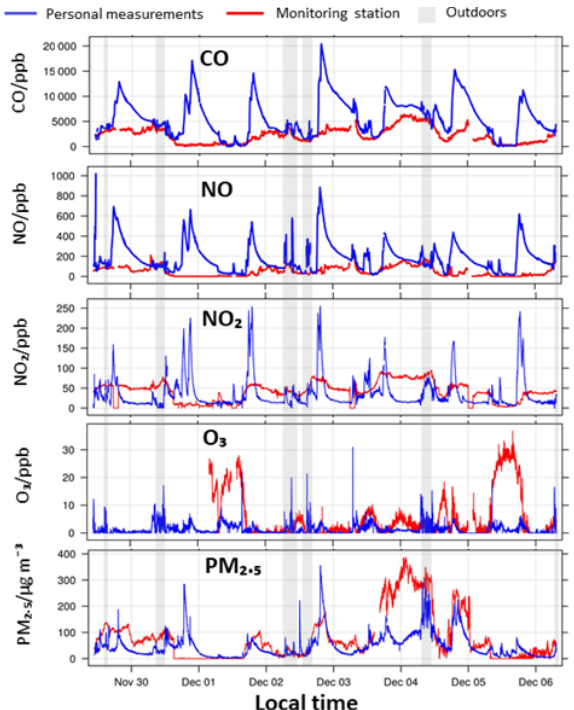
Figure 8. Time series of the air pollution exposure of participant U123 in the AIRLESS project (heating season). Personal exposure measurements (blue) are compared to data from the closest moni- toring station to the participant’s home (red). Grey and white areas indicate the participant is outdoors or at home respectively (based on time–activity